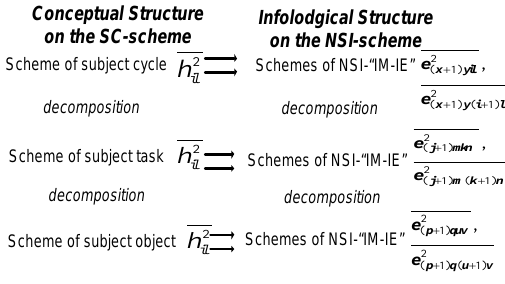
Fig. 5. Mapping pattern of element